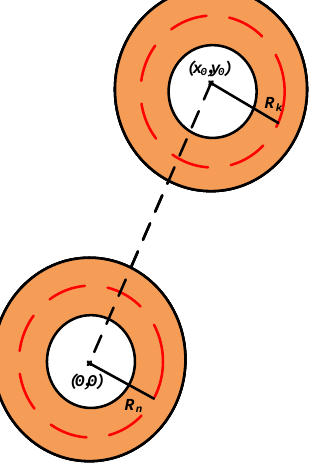
Figure 1. A coupled circular coil system with the primary having i = 1,2..., n turns and the secondary having j = 1,2..., k turns; the radii of the mid-current contour of the n -th primary turn and k -th secondary turn are R n and R k